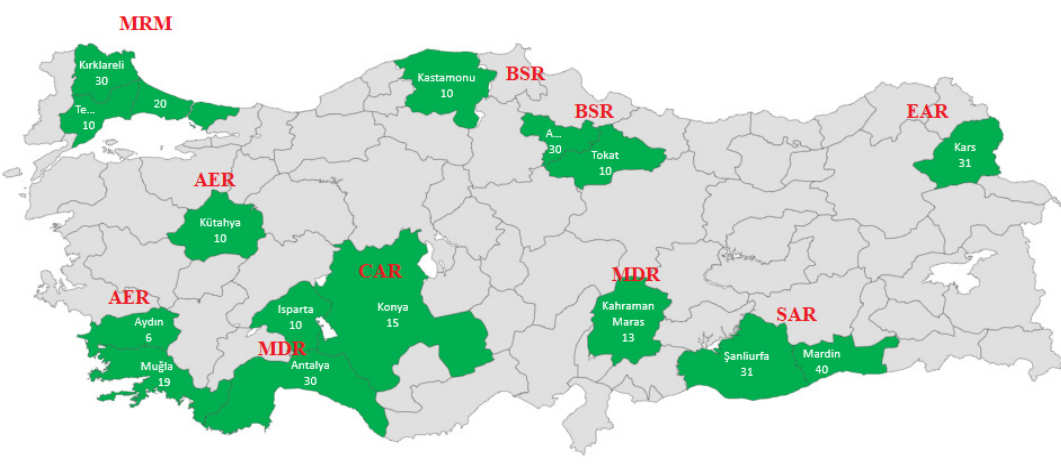
Figure 1. Geographic distribution of the 16 donkey populations included in the study. The details of the regions are given in Table 1. Table 1. The regions, locations, the geographical locations with the number of sample